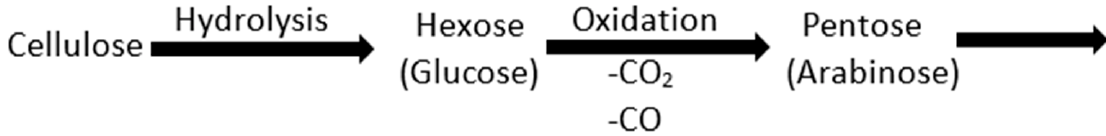
Figure 5. Production of 2FAL through cellulose hydrolysis and oxidation.